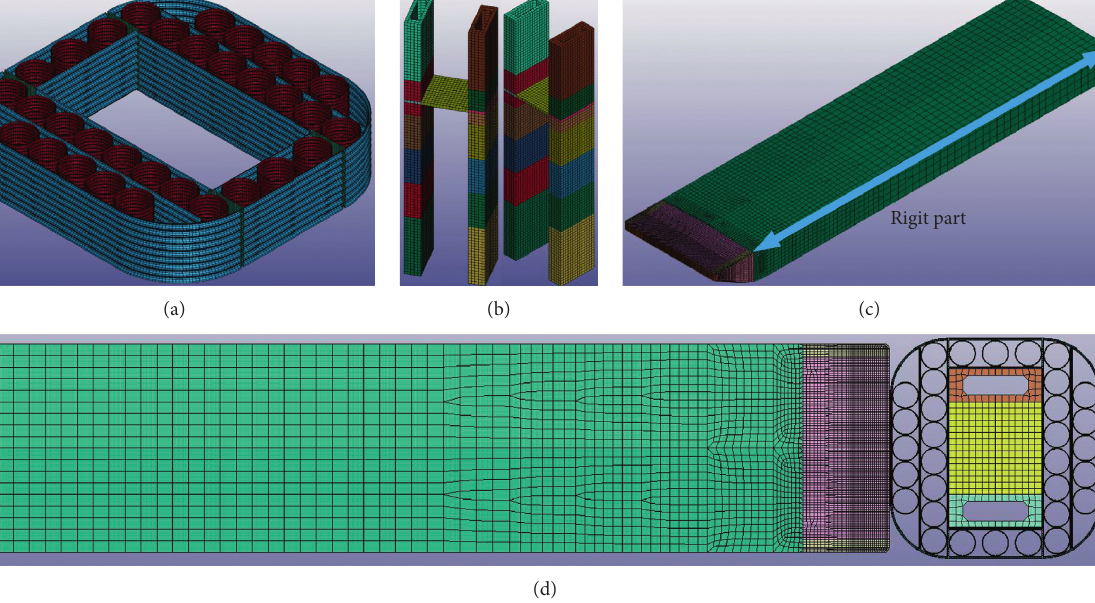
Figure 9: Finite element model: (a) CSP, (b) bridge pier, (c) barge, and (d) head-on